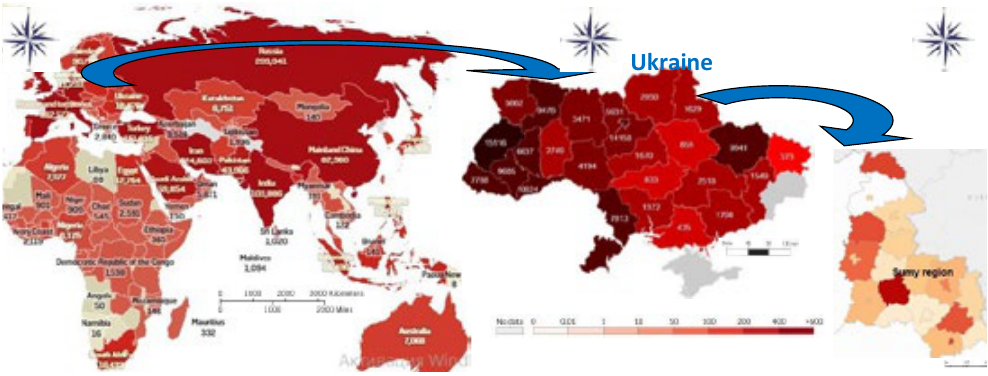
Fig. 1: COVID-19 infection level in rural areas of Sumy region, Ukraine